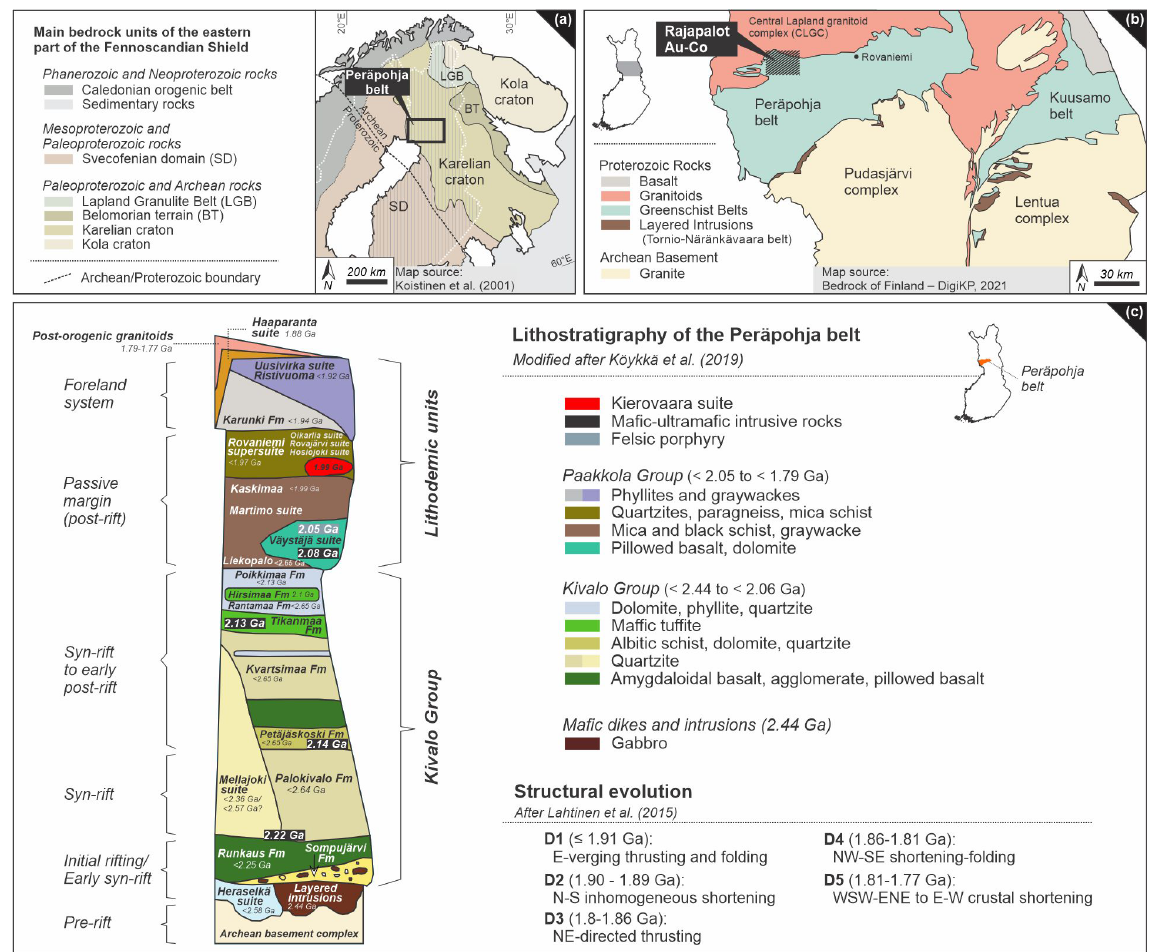
Figure 1. (a) Geologic map of the main bedrock units of the eastern part of the Fennoscandian Shield and the Peräpohja belt as highlighted area (black rectangle). Simplified geological map is based on Koistinen et al. (2001). (b) Geologic map of northern Finland showing Archean and Proterozoic rocks. The Rajapalot Au–Co project is located within the shaded rectangle. Simplified map is modified from the Bedrock of Finland – DigiKP (2021; digital map database of the Geological Survey of Finland). (c) Lithostratigraphy and structural evolution of the Peräpohja belt modified after Köykkä et al. (2019) and Lahtinen et al. (2015),